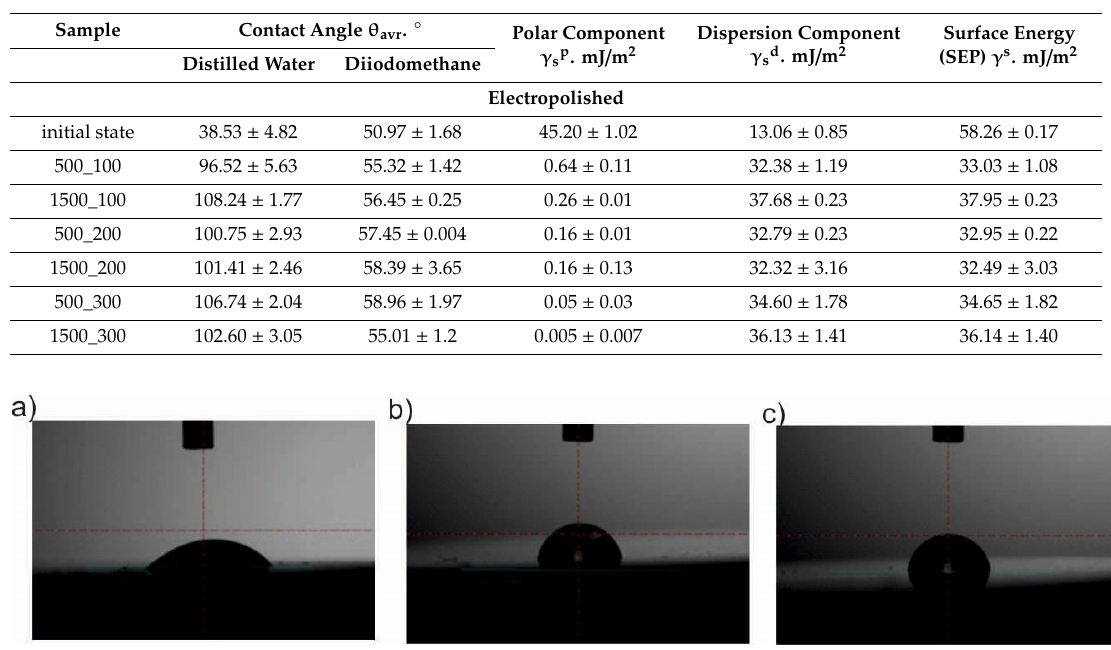
Figure 18. Examples of sessile drops applied to a sandblasted sample: ( a ) initial state; ( b ) 500_200 °C; ( c ) 1500_200 °C.